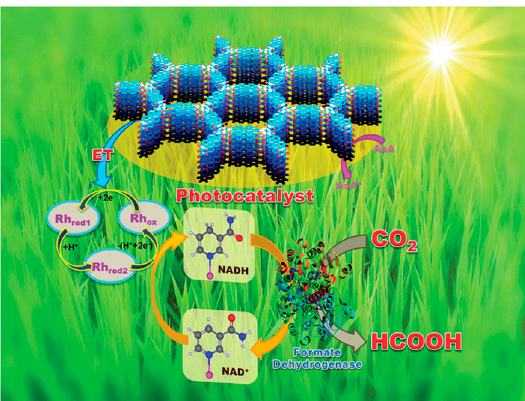
Figure 4. Photocatalytic carbon dioxide reduction to formic acid by CTFs. Reprinted with permission from [80]. Copyright 2016, The Royal Society of Chemistry.